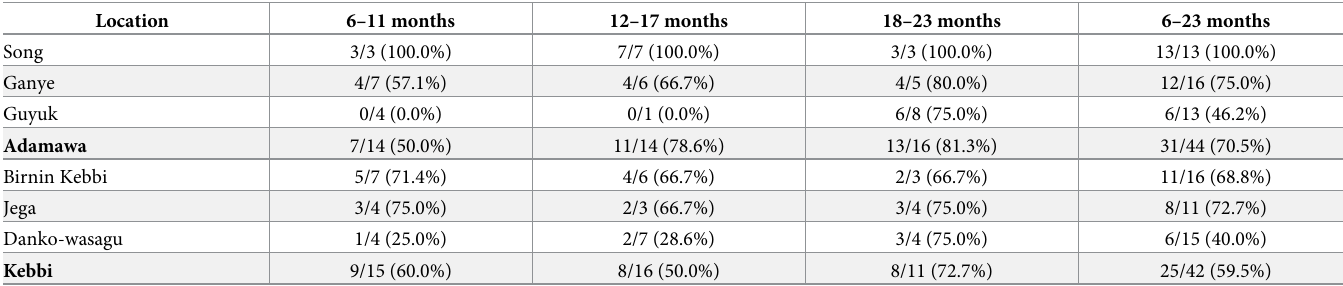
Table 3. Flexible MNP users ( ± 3) according to spot check data by age group and location.